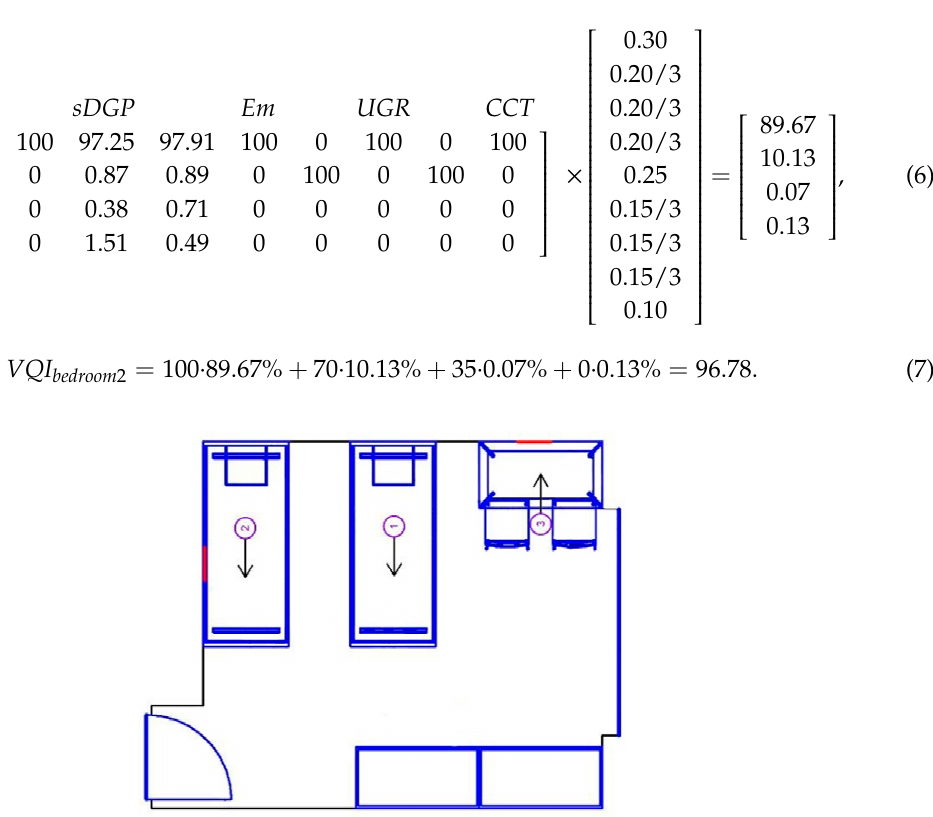
Figure 7. UGR evaluation in Bedroom 2: plan view. •